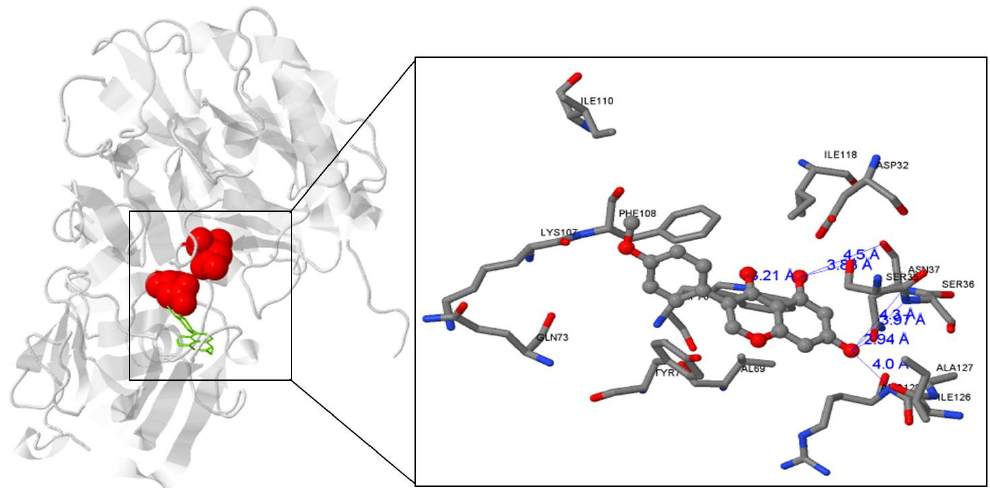
Figure 3. In silico docking poses for biochanin A. The complete view of the docking poses and the close up figure of biochanin A docking modes ( left ). Human BACE1 is expressed as a gray solid ribbon diagram and biochanin A as a green representation. Asp32 and Asp228 are the active catalytic center residues marked in red. Hydrogen bond interactions between biochanin A and human BACE1 residues are displayed as a blue line ( right ). The structural ligands were performed by AutoDock Vina.